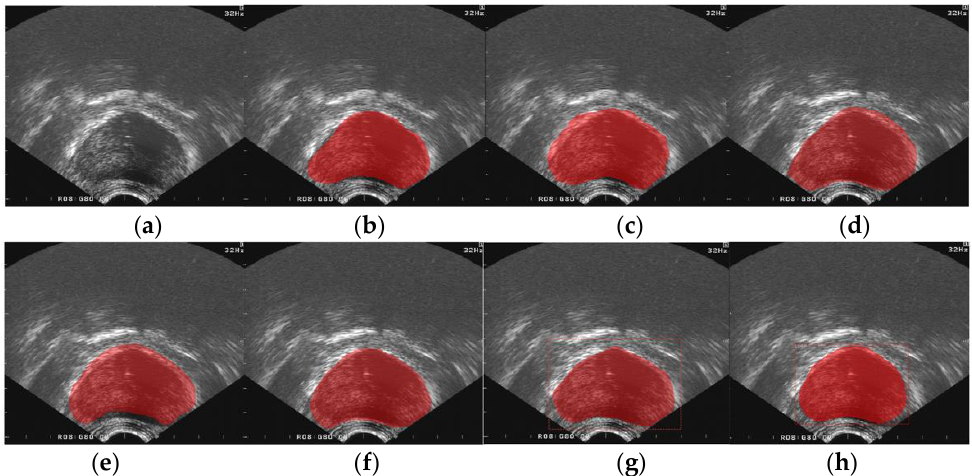
Figure 9. Segmentation results of different methods: ( a ) original prostate TRUS images; ( b ) active shape model (ASM); ( c ) fully convolutional networks (FCN) [14]; ( d ) U-Net [15]; ( e ) SegNet [16]; ( f ) Deeplab v3 [17]; ( g ) Mask R-CNN [7]; ( h ) our methods.